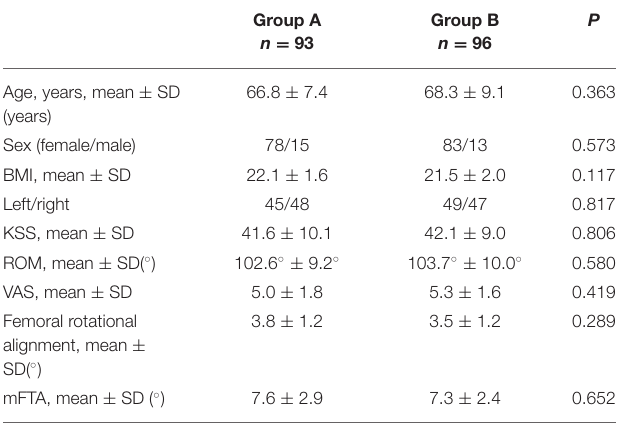
TABLE 1 | Comparison of baseline characteristics between the two groups.